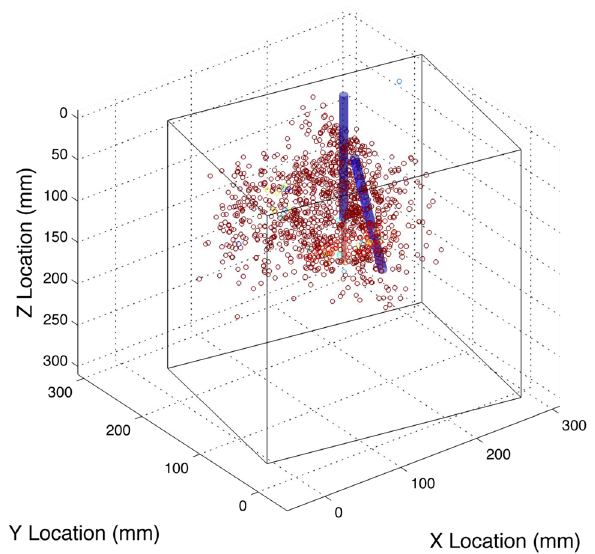
Fig. 6 3D view of the filtered AE event source locations and injection (vertical) and production (angled) wellbores